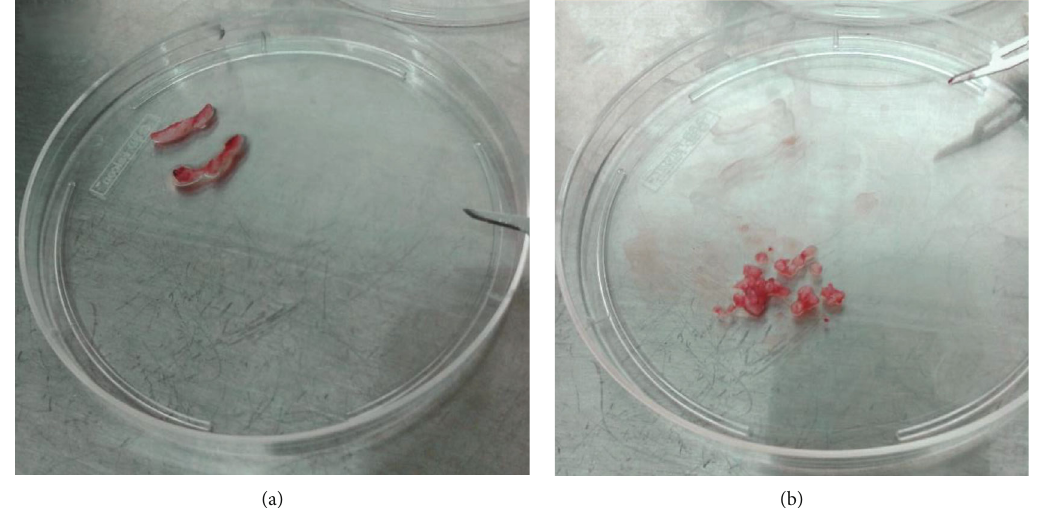
Figure 1: (a) Healthy gingival tissue specimen of discarded crown lengthening procedures. (b) Gingival connective tissue was meshed to 1mm pieces using a surgical